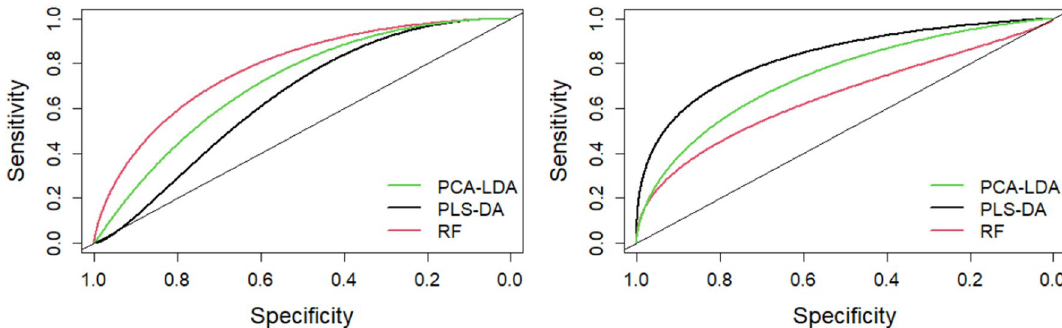
Figure 4. Performance measurement of the chemometric methods as described by a smoothed ROC curve considering the 1800–900 cm −1 (left panel) and 3050–2800 cm −1 (right panel) spectral